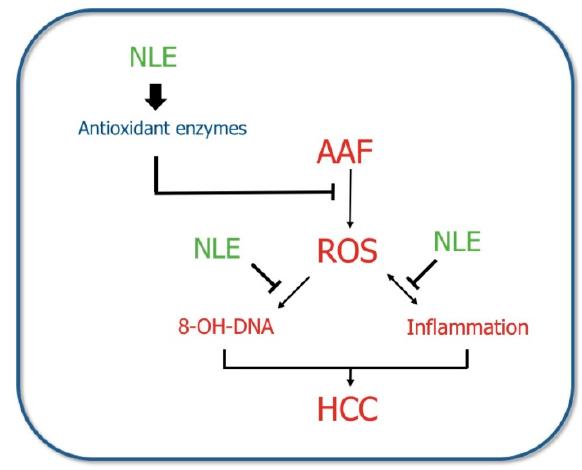
Figure 7. Mechanism of inhibition of hepatic damage by NLE.